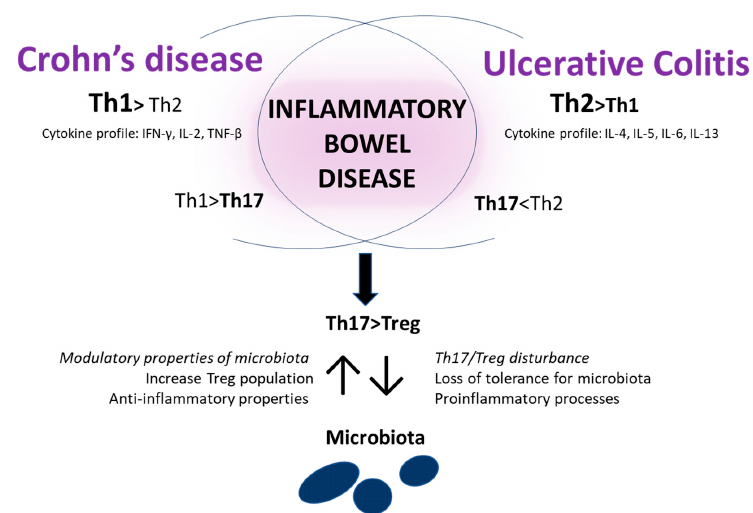
Figure 2. The role of the immune response in IBD. In CD, Th1 skewing is observed, but in UD, Th2 skewing is common. The population of Th17 cells is decreased regarding the Th1 or Th2 population. The decreased number of Treg cells and imbalance in Th17 and Treg subpopulation are common in both diseases. The subpopulation disturbance triggers the loss of tolerance for microbiota and the privilege of the proinflammatory processes. In turn, microbiota modulates the Treg population and has an anti-inflammatory effect.